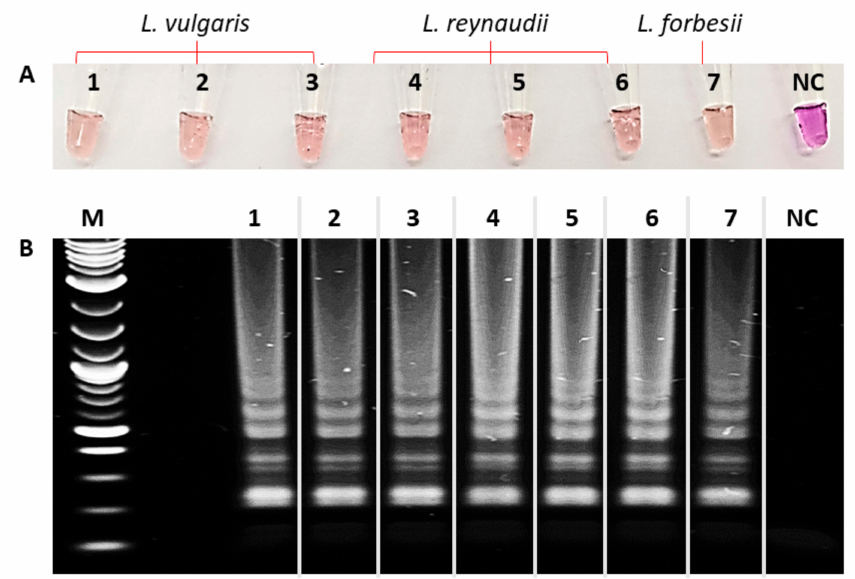
Figure 3. Colorimetric LAMP positive control applied on samples. 1 – 3 : L. vulgaris , 4 – 6 : L. reynaudii , 7 : L. forbesii , NC : pure water. ( A ) Colorimetric result. ( B ) 1% agarose gel; M : molecular weight